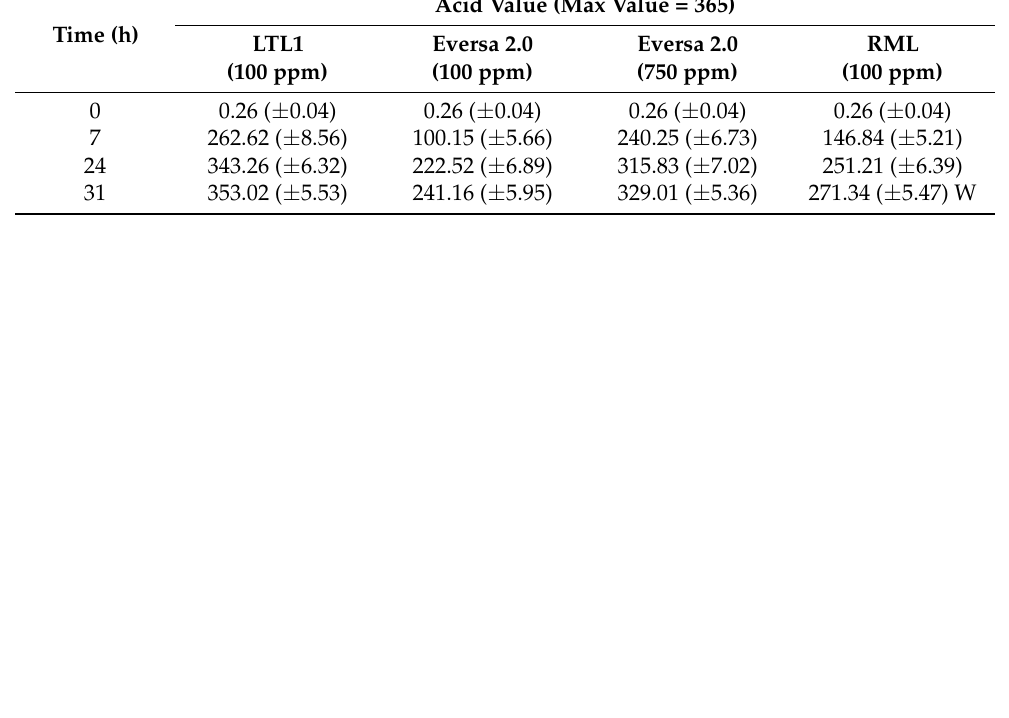
Table 1. Hydrolysis of C8-C10 ME by LTL1, RML and Eversa 2.0.